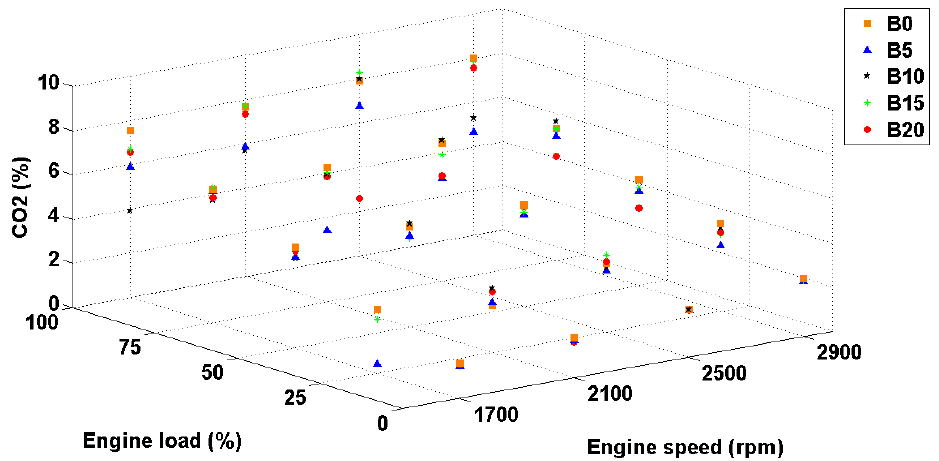
Figure 14. CO 2 emissions of the engine under different engine loads, speeds and biodiesel percentages.